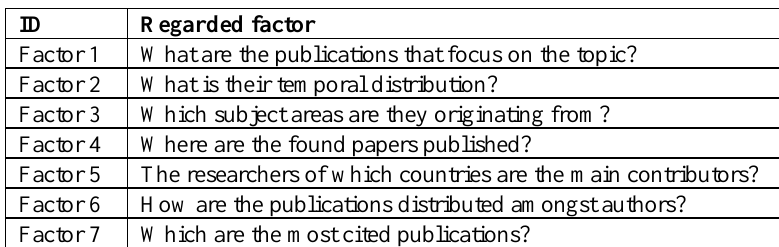
Table 4. Considered factors for answering